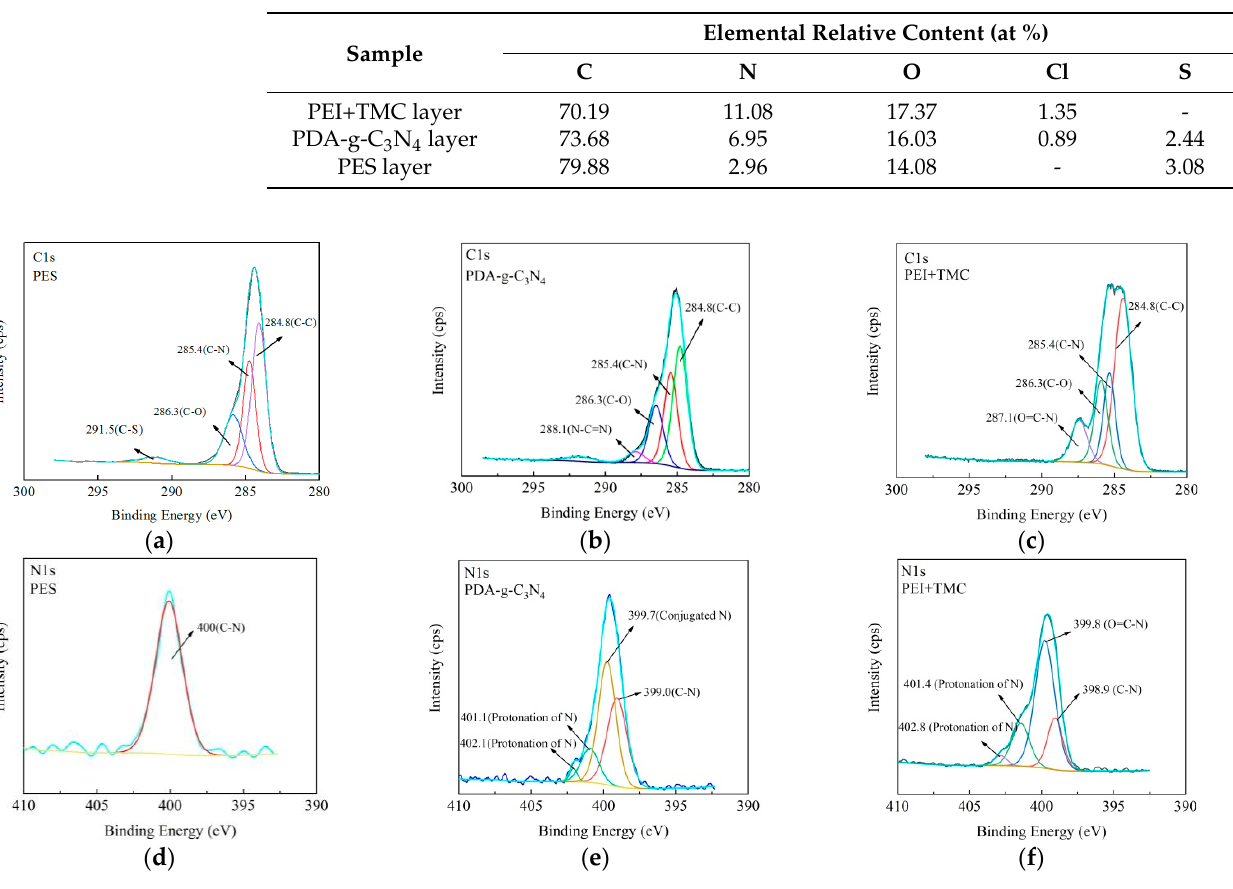
Figure 4. In situ high resolution C1s spectra ( a – c ) and N1s spectra ( d – f ) of the M5 membrane.